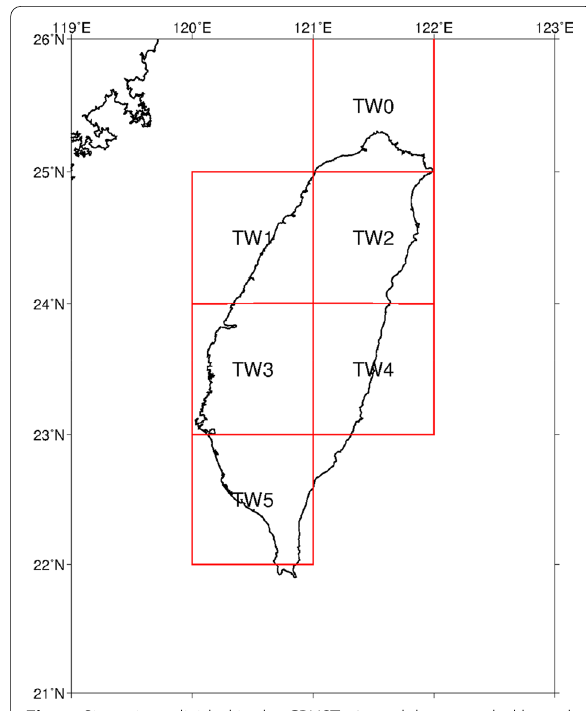
Fig. 1 Six regions divided in the CRUST1.0 model surrounded by red